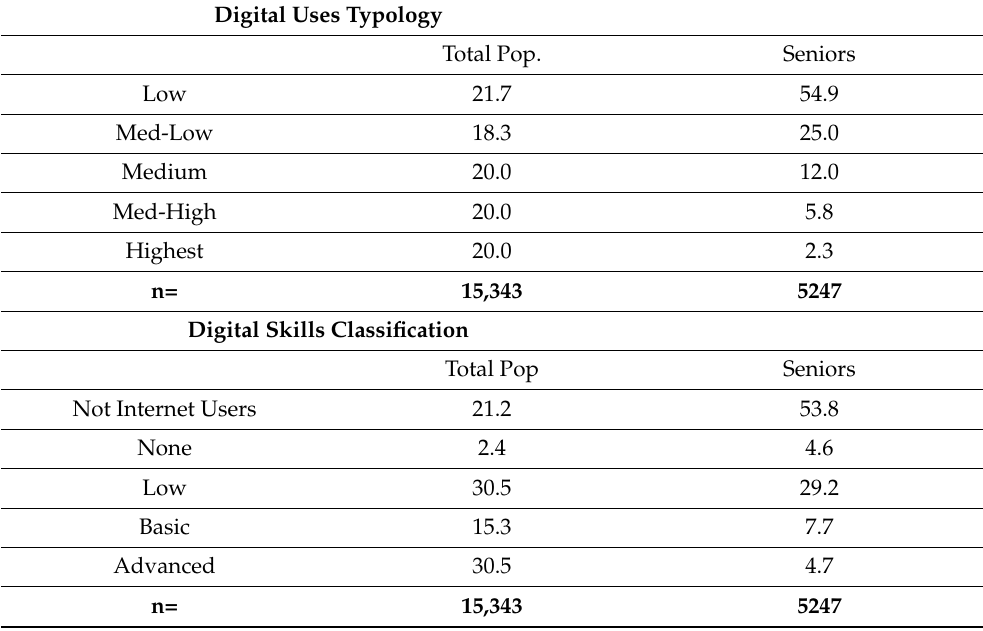
Table 3. Digital variables: seniors and total